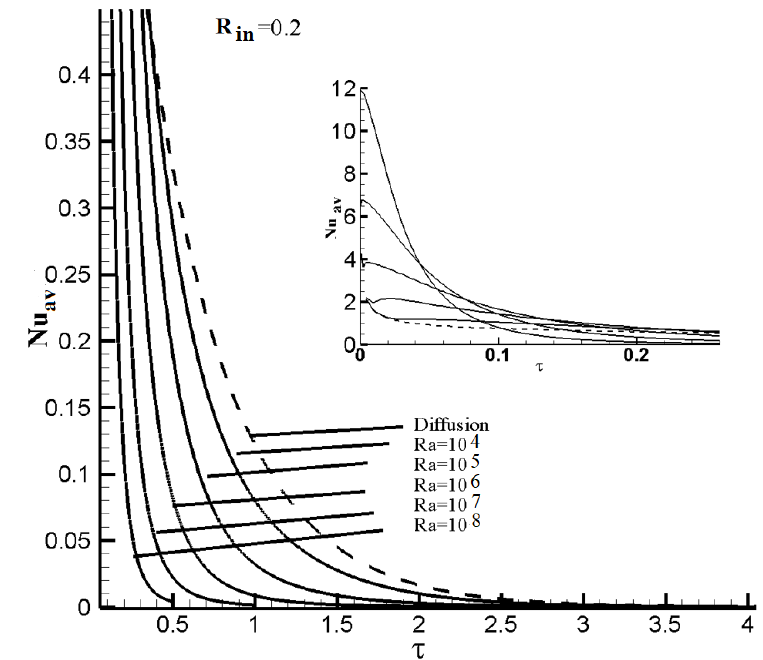
Figure 7. Nusselt number as a function of time for different Ra and for R in = 0.2.